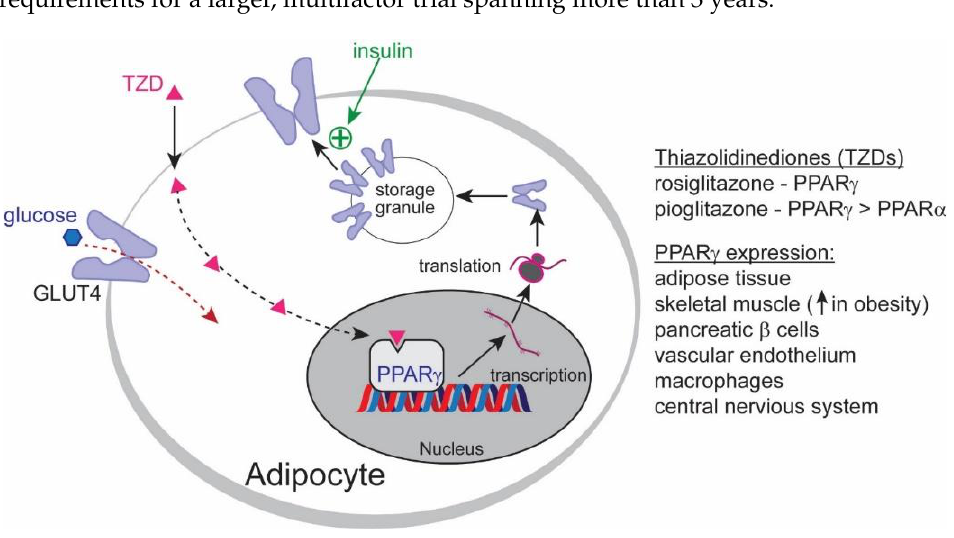
Figure 2. Mechanism of action of pioglitazones. Pioglitazone directly binds and activates PPARγ in the nucleus, increasing the expression of GLUT4 proteins embedded in the cell membranes of storage granules. Upon signaling by insulin, a fusion of storage granules results in the increase in GLUT4 transporters in the cells, increasing the uptake of glucose into cells — thereby increasing insulin sensitivity and glucose tolerance.